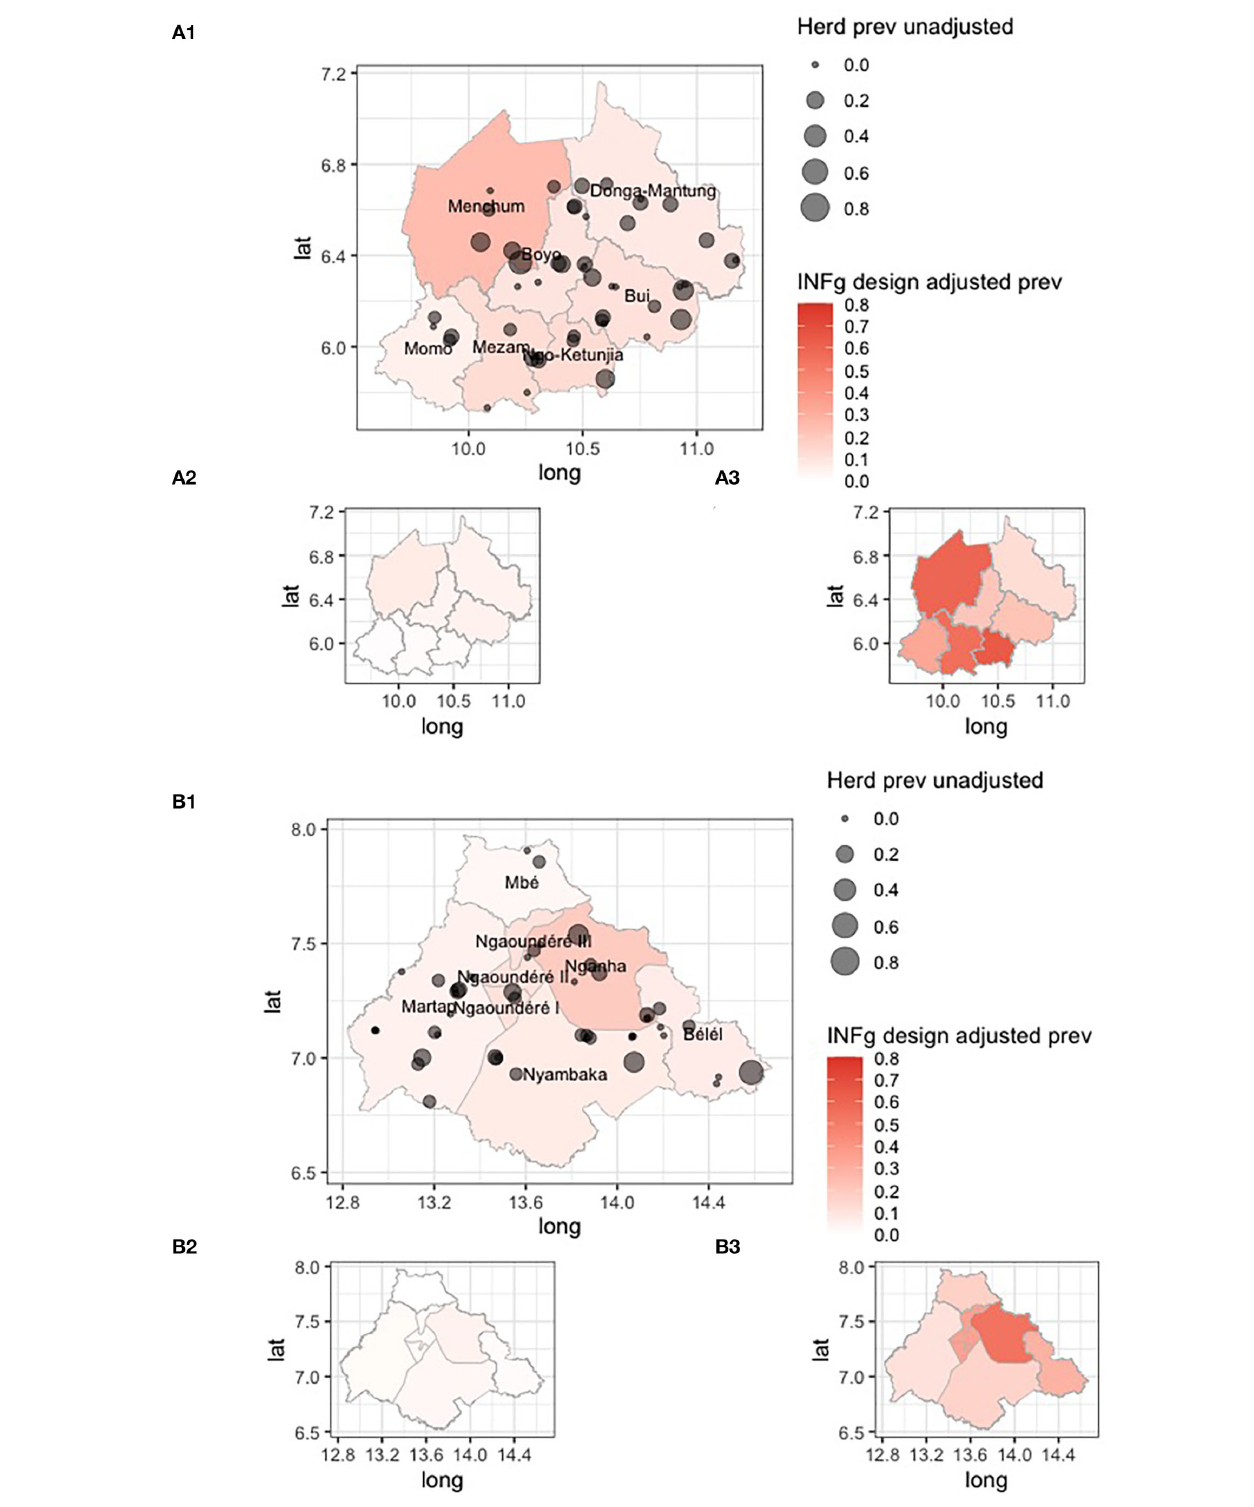
FIGURE 5 | Choropleth maps of the Northwest Region (NWR) (A1) and Vina Division (VIN) (B1) in Cameroon colored by design adjusted IFN- γ prevalence for the administrative strata, overlaid with the approximate location of individual herds sized by the raw proportion of animals positive within each herd. The smaller inset choropleth maps are for the lower (A2,B2) and upper (A3,B3) 95% confidence intervals, respectively.